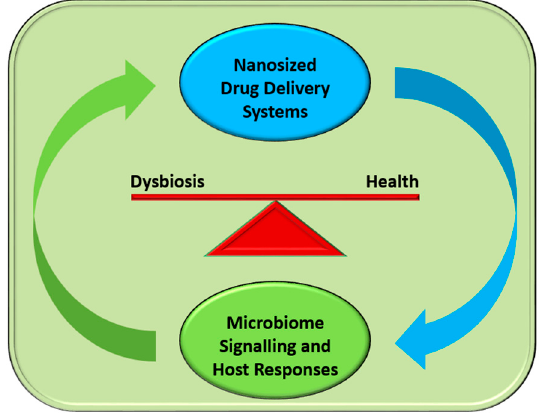
Figure 1. The intimate interactions between microbiome and nanomaterials. The complex biological signalling exchanges unfolding regularly during the encounters of drug-transporting nanoparticles and microbiota influence microbiome composition and, hence, the balance between health and disease (dysbiosis).